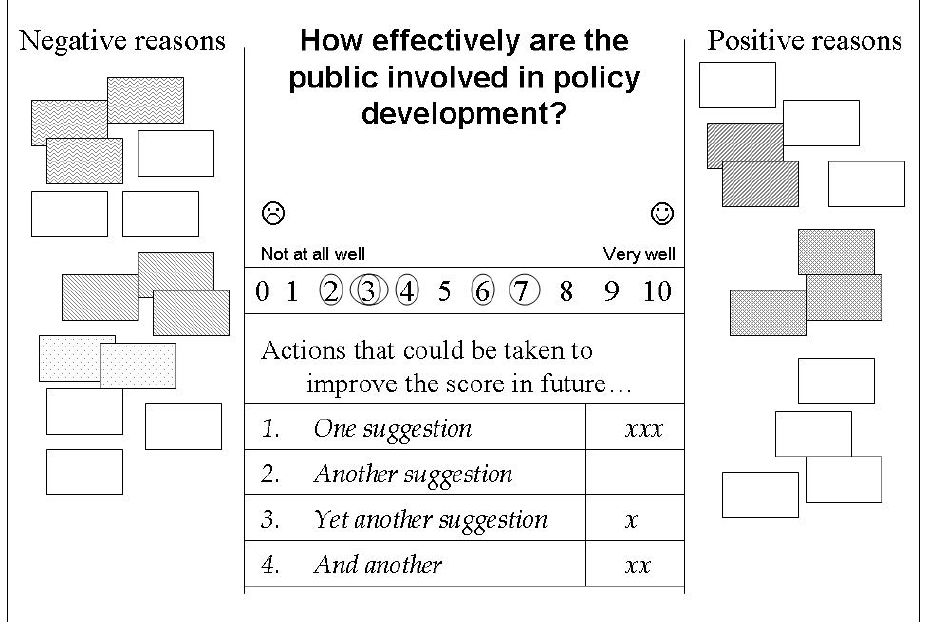
Figure 1: Diagram of a completed H-form (each ‘ x ’ represents one